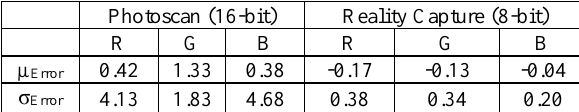
Photoscan (16-bit) Reality Capture (8-bit)